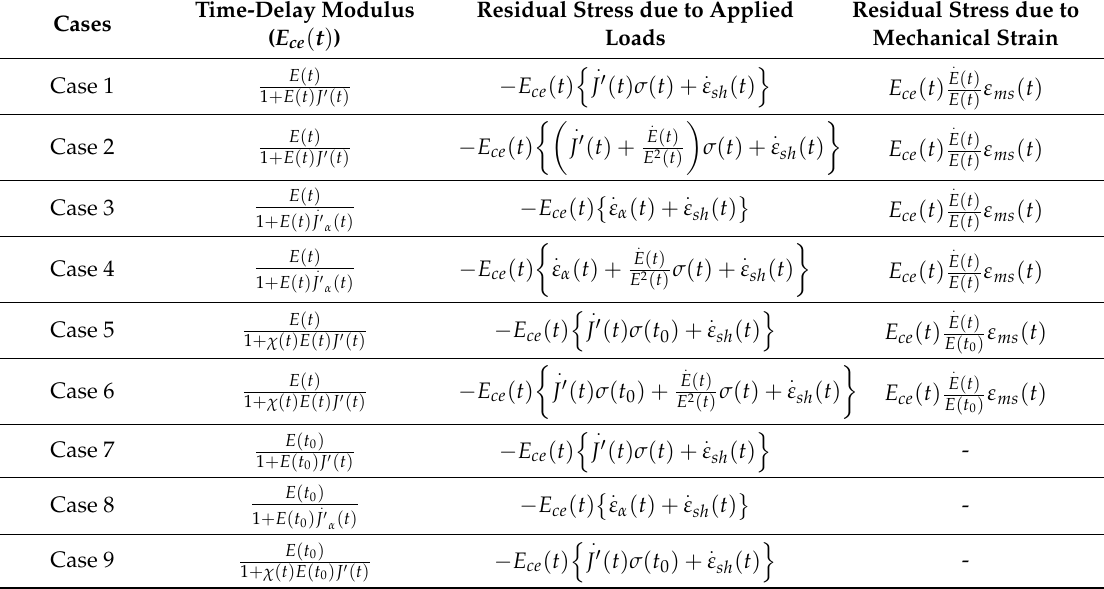
Table 4. Nine constitutive